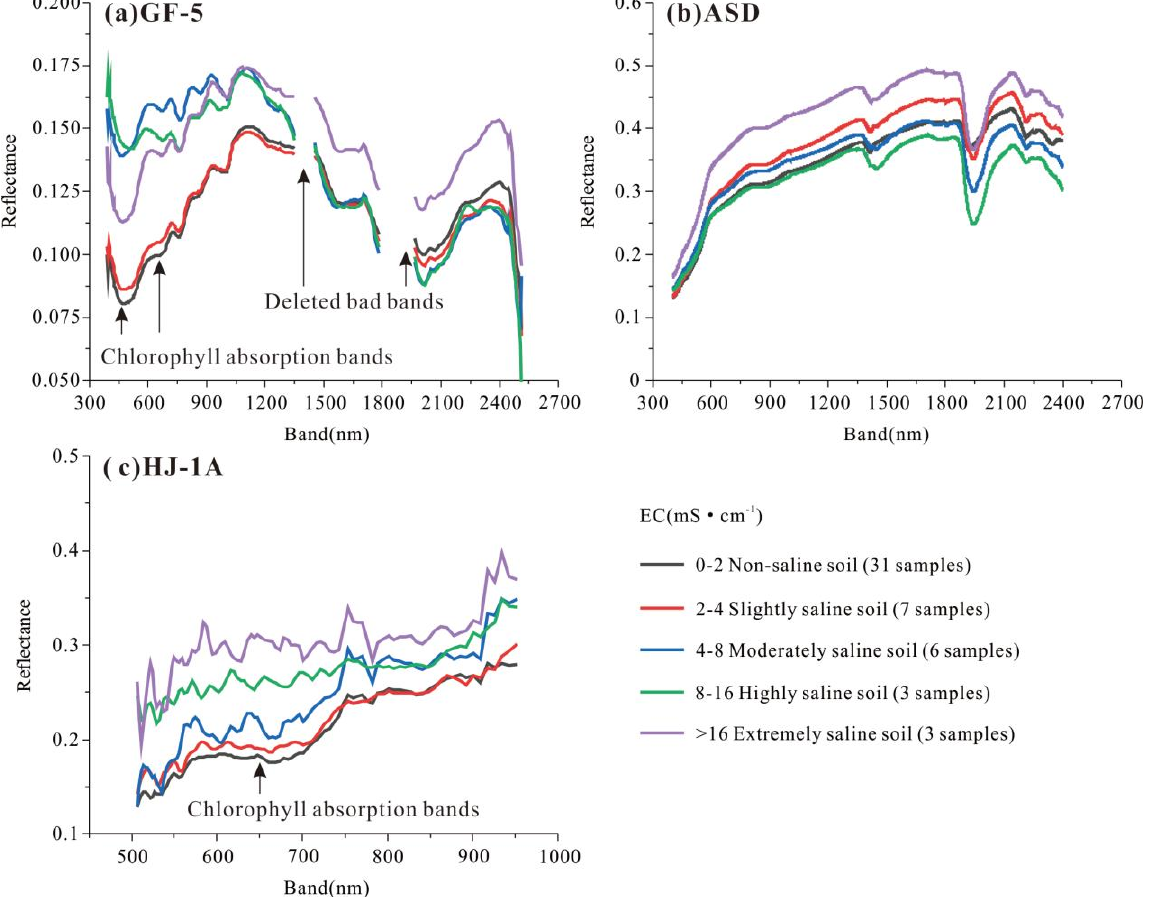
Figure 5. GF-5 ( a ), ASD ( b ), and HJ-1A ( c ) spectra curve of soil samples corresponding to different EC values (the number in parentheses was the sample size, and the classification standard of saline soil referred to the research of Ivushkin et al. [66]. The deleted bad bands of GF-5 were seriously influenced by water).